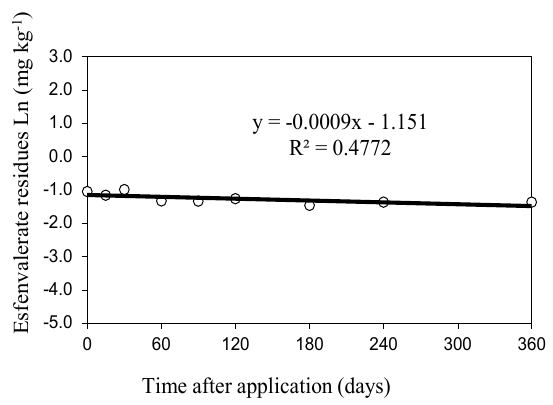
Figure 1. Mean values of fenitrothion residues through time after treating wheat grains with the Sumigranplus® formulation. Values have been logarithmically transformed and the regression has been adjusted.